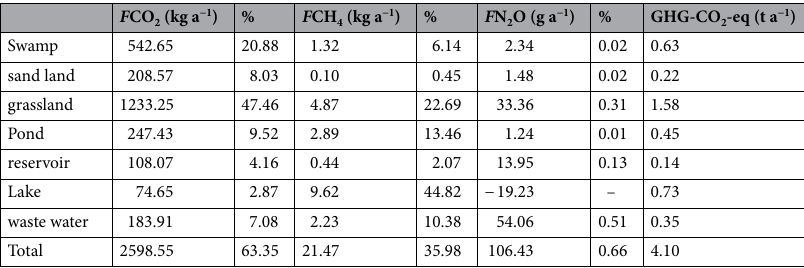
Table 2. Emissions of greenhouse gas in the Xilin river under different land use types.